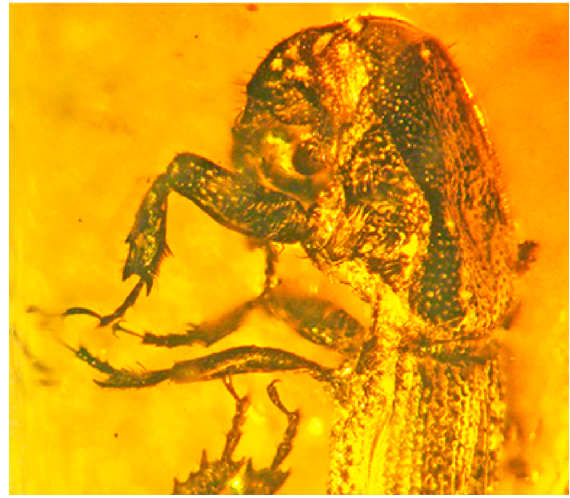
Figure 2. Gongyloceria dominicana sp. nov., holotype—Dominican amber: detail of head and lateral view. Material examined : Holotype—PACO # 92, Dominican amber. Etymology : The species epithet indicates the place of origin of the fossil. Genus: Xyleborites Wickham, 1913 , placem. n. (Figure 3) Xyleborites longipennis (Wickham 1913)—Florissant